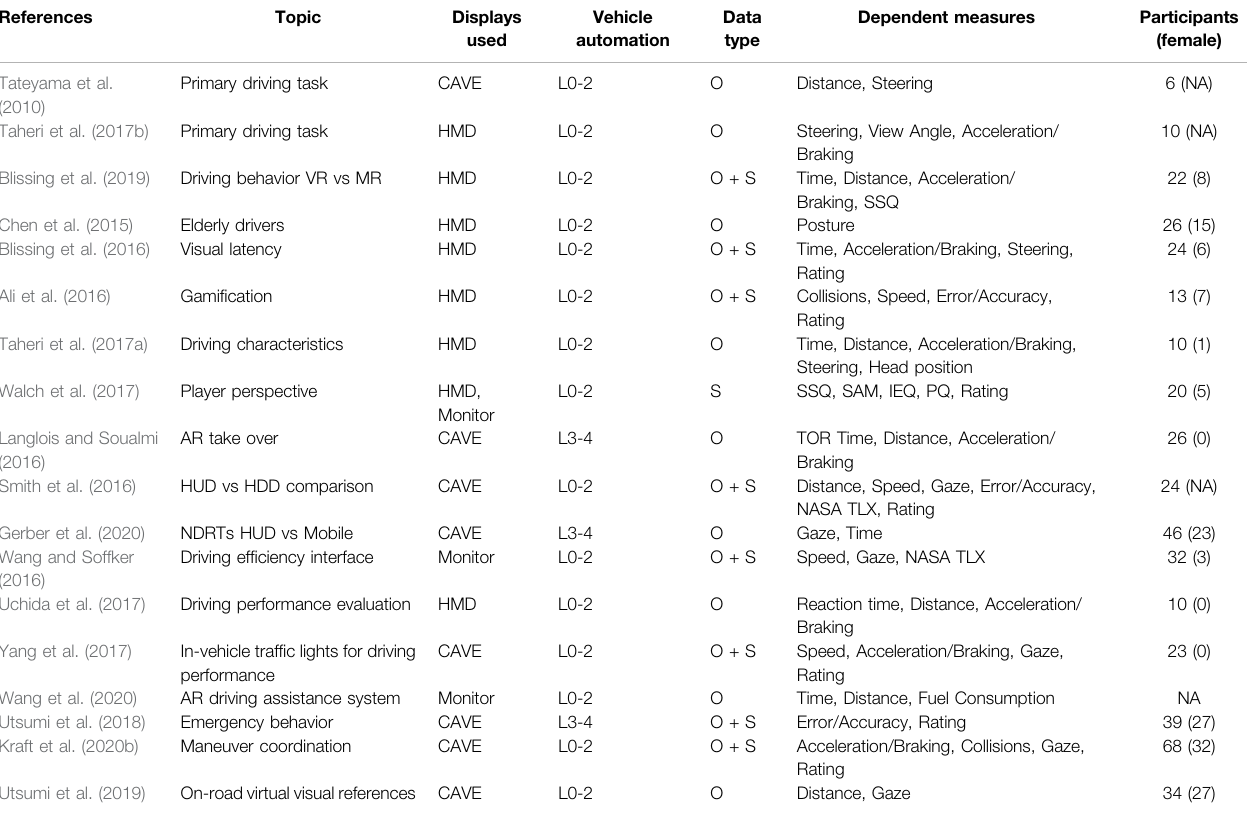
TABLE 4 | Summary of user studies in Driving Behavior application